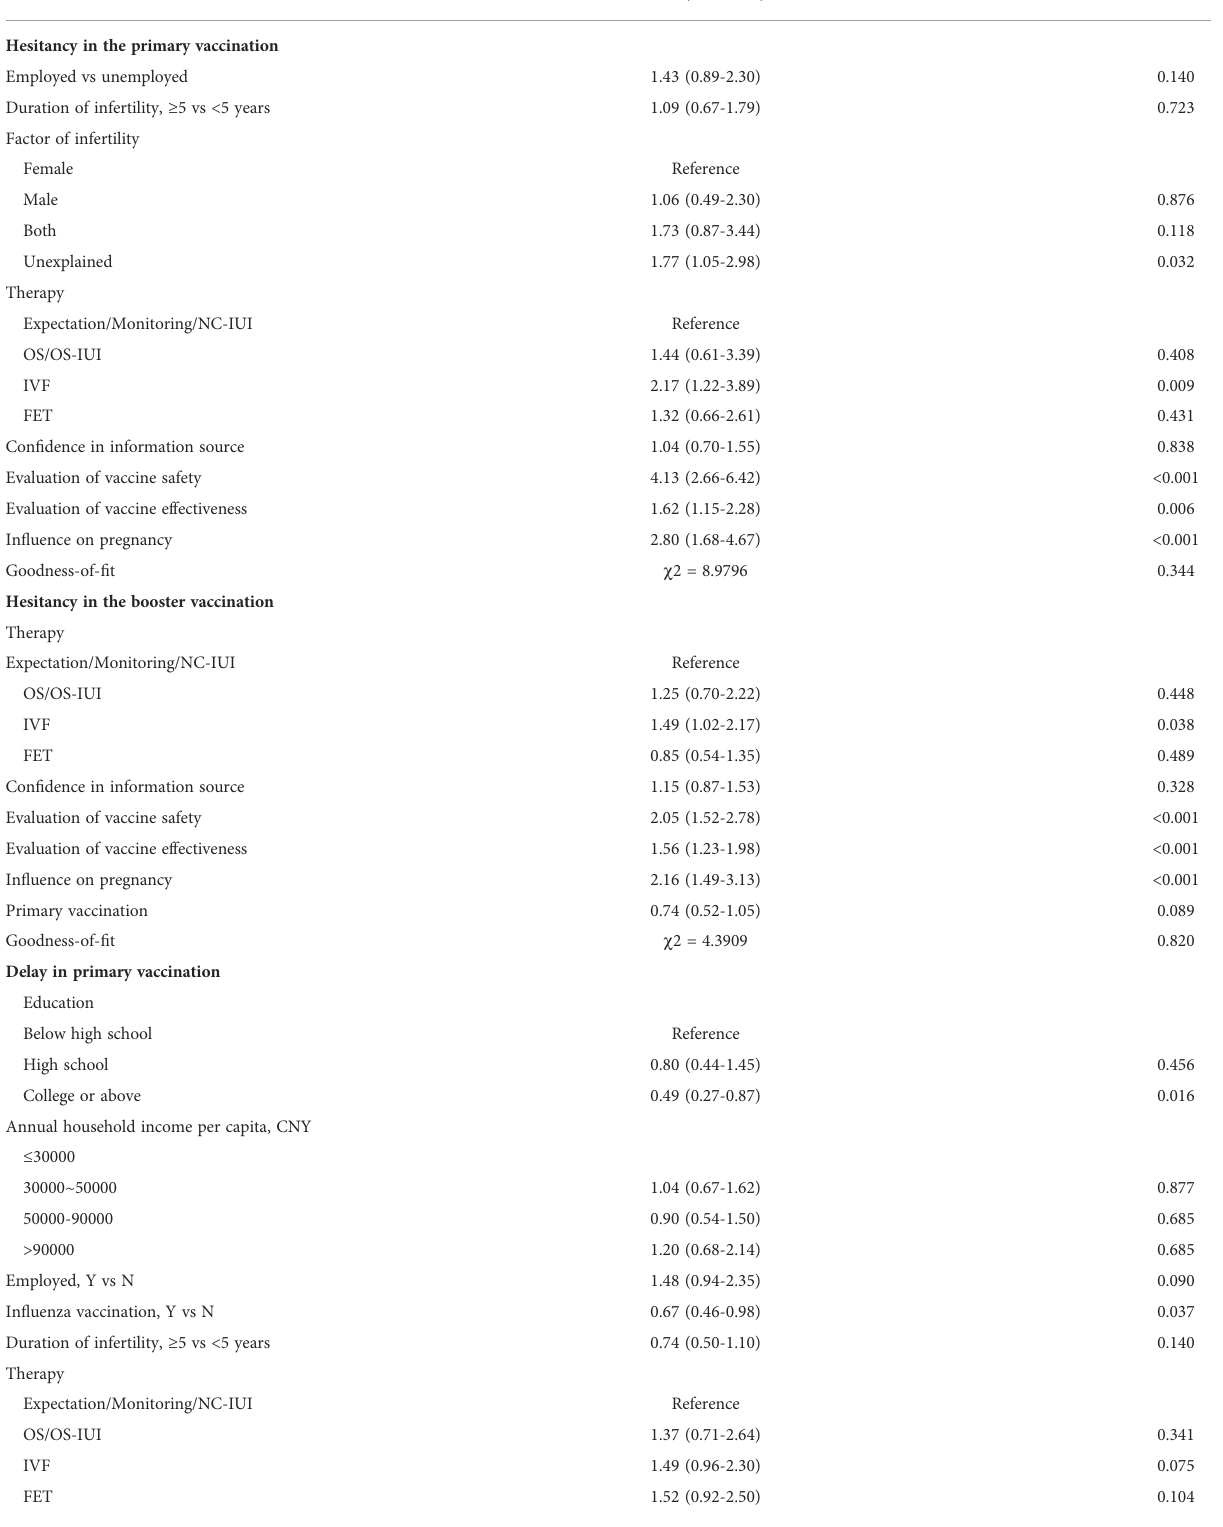
TABLE 3 Associated factors of COVID-19 vaccine hesitancy and coverage rate (multivariate